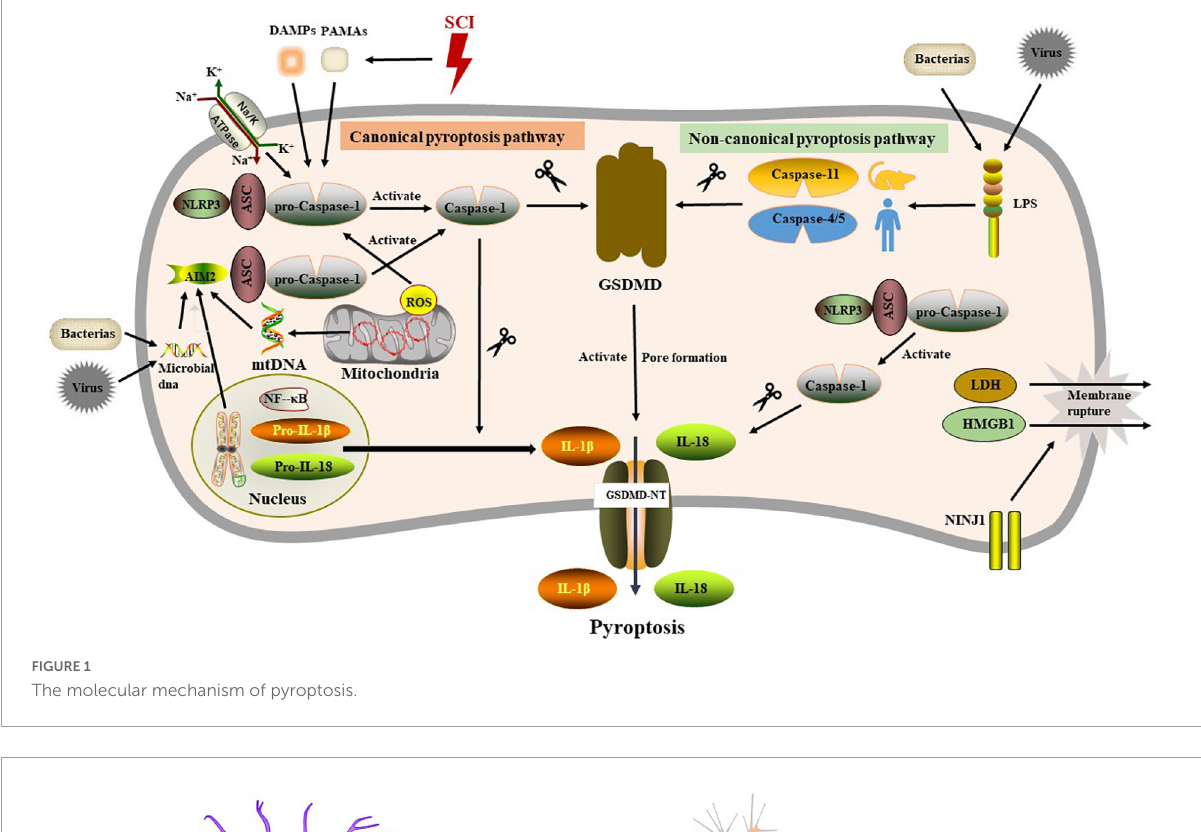
FIGURE1 The molecular mechanism of pyroptosis.